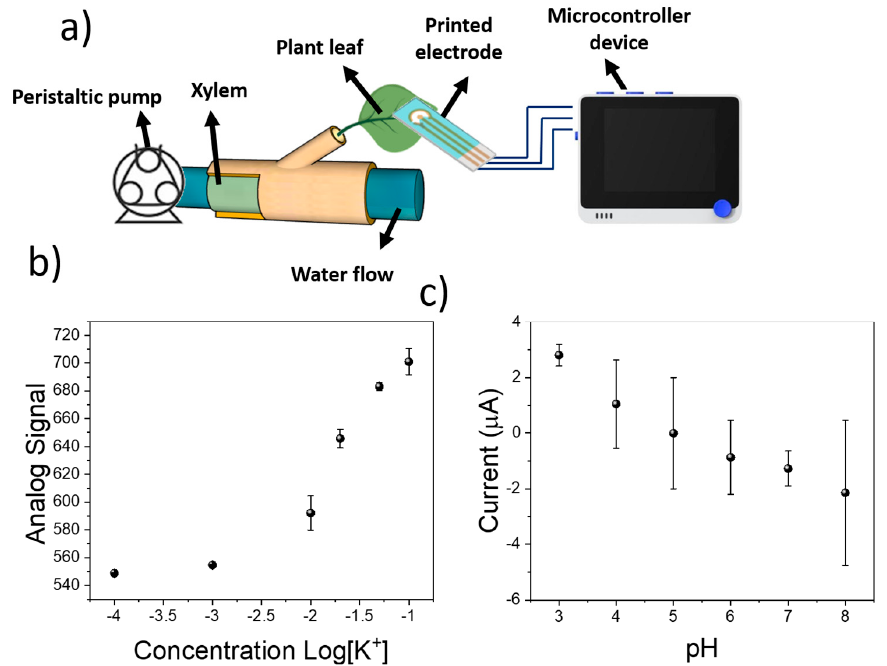
Figure 5. ( a ) Schematical representation of the system employed for the calibration of sensing devices in plants. The sensing electrodes were placed onto plant leaves and connected to a microcontroller for the sensing. ( b ) Calibration plot of screen-printed electrodes subjected to different KCl concentration in the plant xylem. ( c ) pH calibration of sensing devices by determination of current on RuO x electrodes.